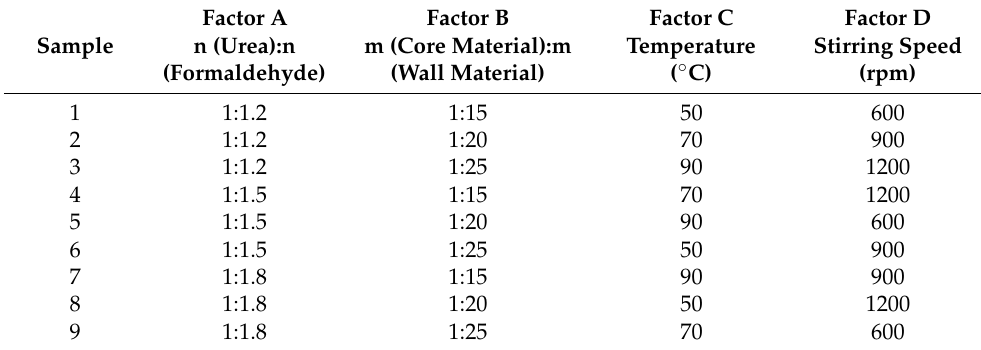
Table 3. Preparation parameters of the orthogonal experiment.